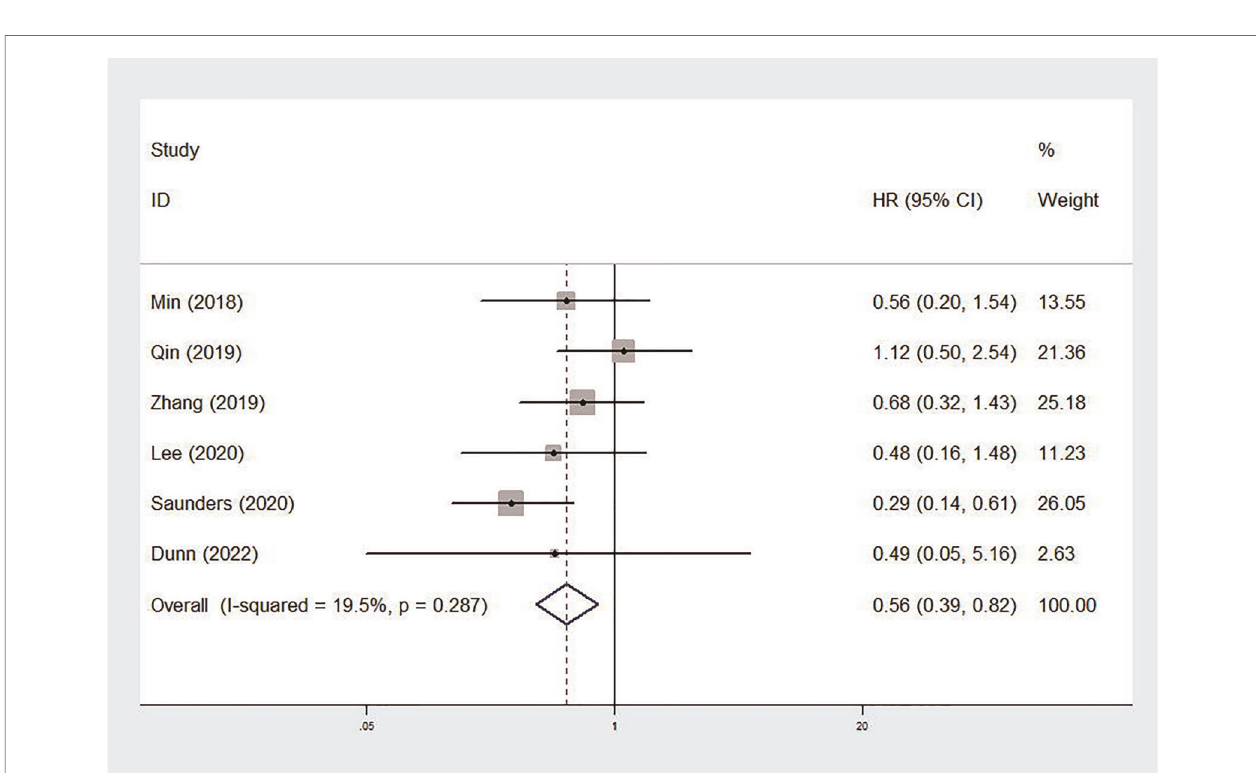
FIGURE 3 | Comparison of disease-speci fi c survival between patients receiving endoscopic dissection and